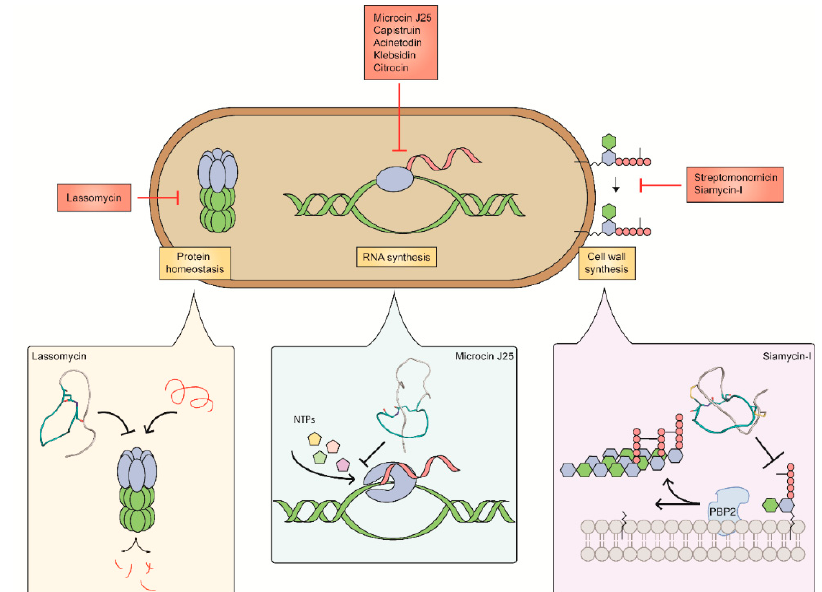
Figure 6. Targets and mode of action of lasso peptides. The known antibacterial targets of lasso peptides include inhibiting protein homeostasis, RNA synthesis, and cell wall biosynthesis. The mechanism of action of lasso peptides is shown for lassomycin, the only protein homeostasis inhibitor, microcin J25, the model lasso peptide and first to be shown as an inhibitor of RNAP, and siamycin-I, the first lasso peptide to target lipid II in peptidoglycan.